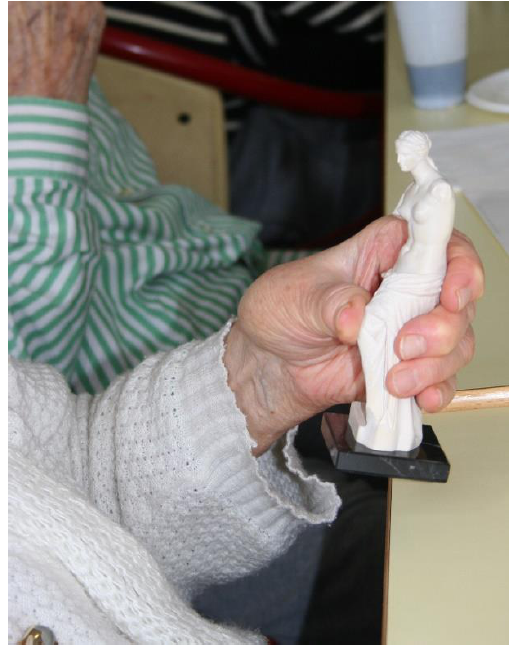
Figure 2. Art guided discussion about the Venus de Milo.